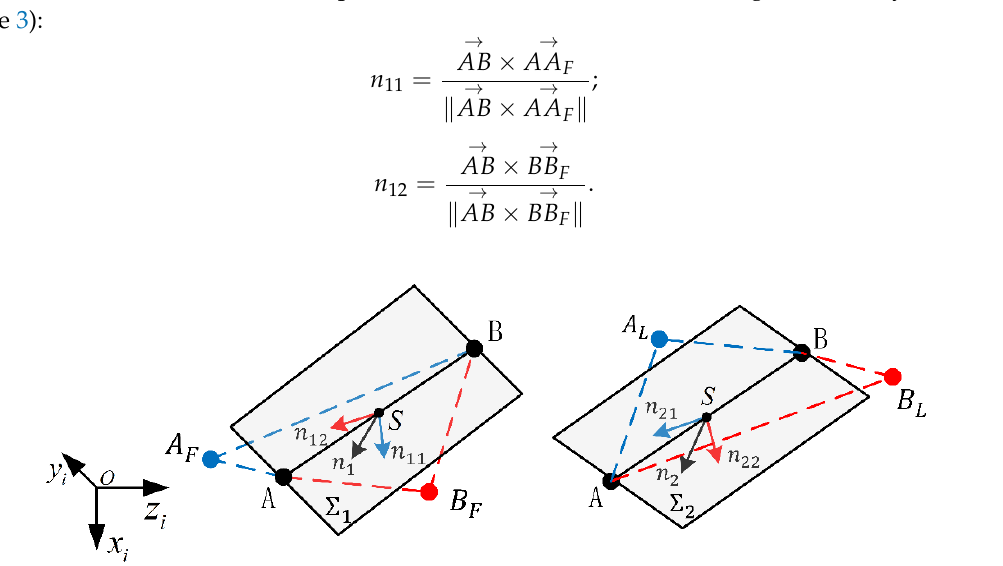
Figure 3. Determination of the virtual-support plane.